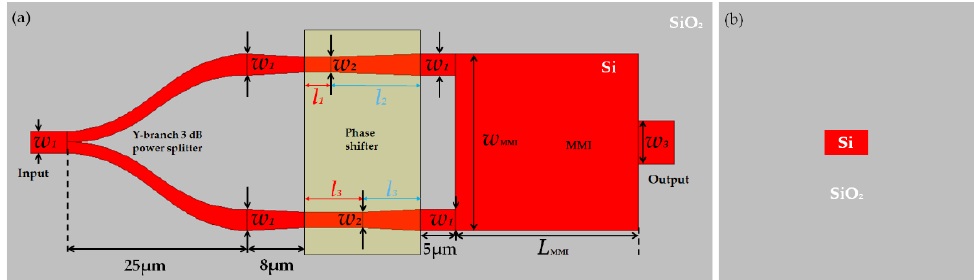
Figure 2. Schematic diagram of the ( a ) E 00 -E 10 silicon mode converter, and ( b ) cross-section of silicon waveguide.